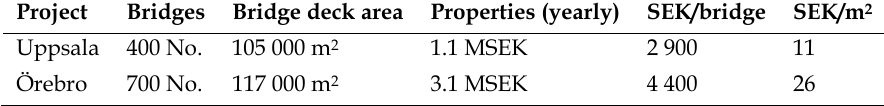
Table 8. Key figures for measures.